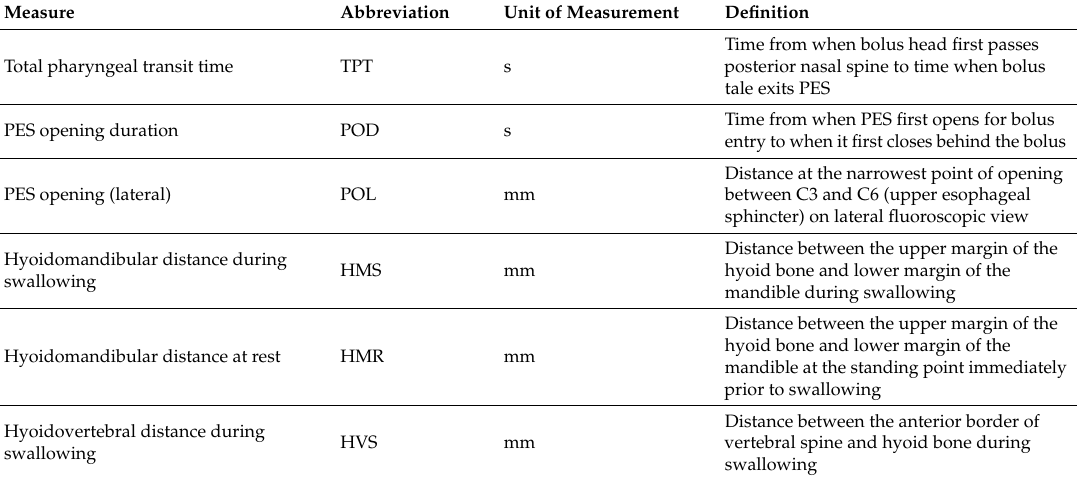
Table 3. Temporal and spatial videofluoroscopic measures.